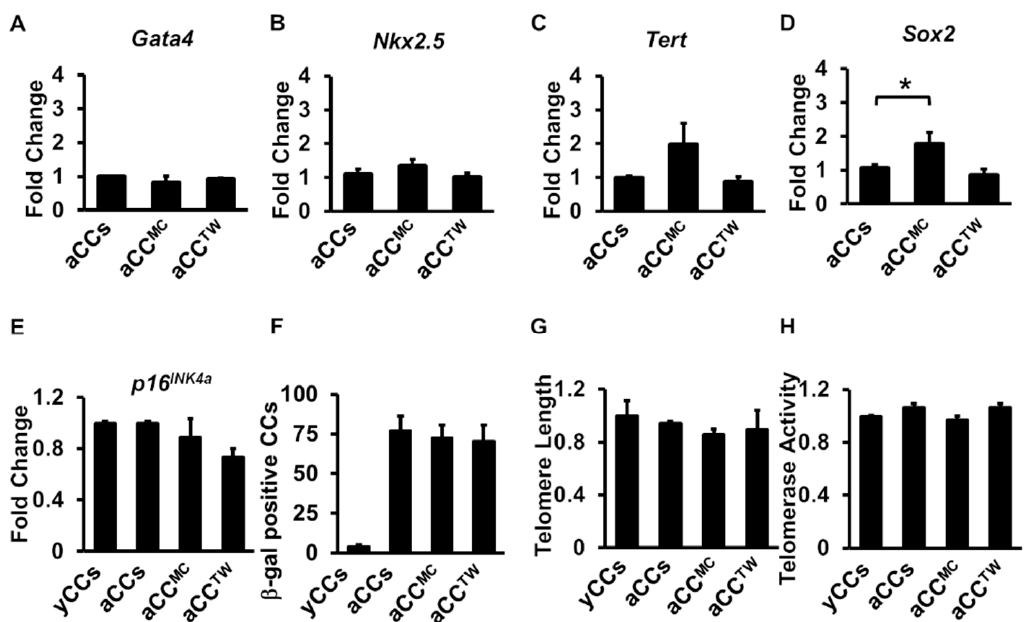
Figure 6. Co-culture with MSCs failed to rejuvenate aged CCs in five days of co-culture. ( A – D ) Stemness gene expressions ( Gata4, Sox2, Tert , and Nkx2.5 ) as performed by qPCR. ( E ) p16 INK4a gene expression of CCs ( F ) β -galactosidase assay for detection of senescent cells. ( G ) Relative telomere length and ( H ) relative telomerase activity of CCs following co-culture. All data are mean ± SEM. * p < 0.05. ( n = 3).